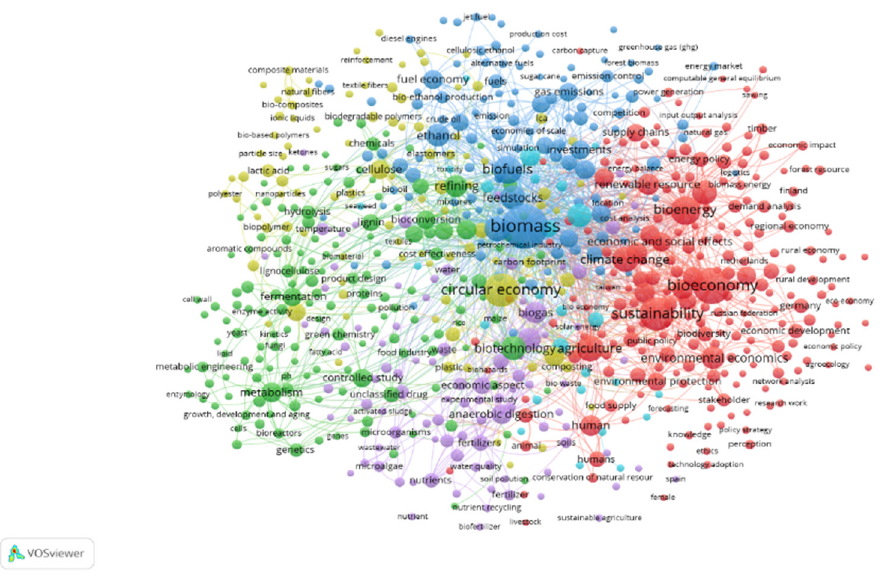
Figure 3. Co-occurrence network map of the most used keywords related to agricultural